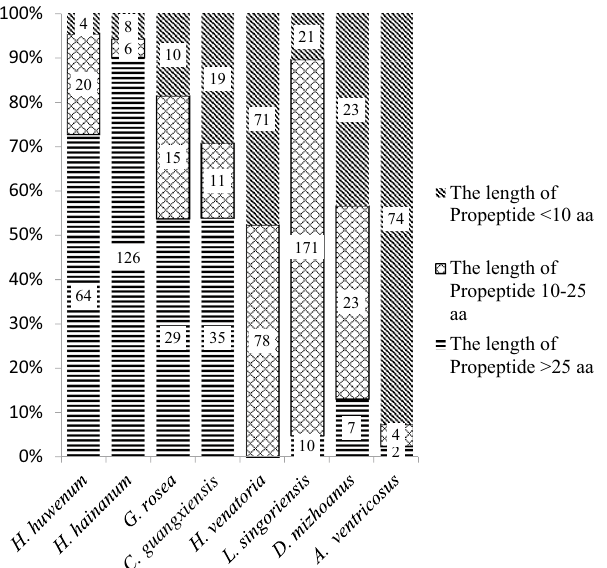
Figure 3. The distribution of the length of propeptide in eight spider species. The species of Mygalomorphae are C. schmidti, C. hainanus, G. rosea and C. guangxiensis , and the species of Araneomorphae are L. singoriensis, D. mizhoanus , A. ventricosus and H. venatoria. The figure was conducted in Microsoft Excel 2010.